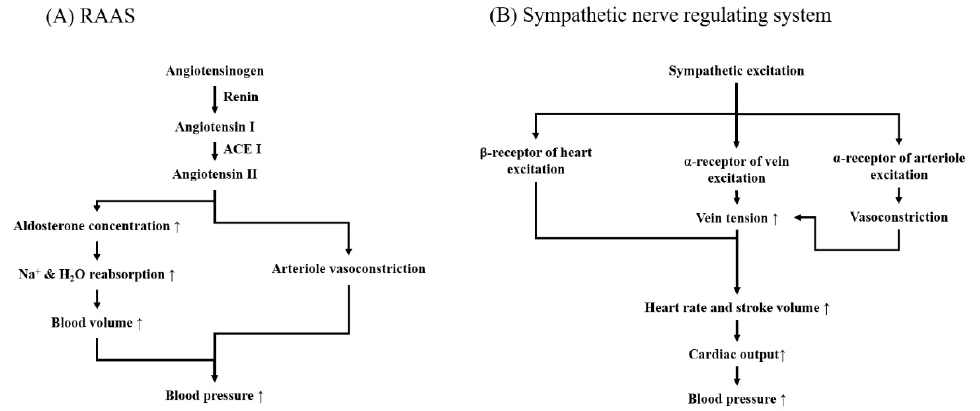
Figure 1. Regulating mechanism for blood pressure. ( A ) RASS; ( B ) Sympathetic nerve regulating system. RAAS: renin-angiotensin-aldosterone systems; ACE I: angiotensin converting enzyme inhibitor.